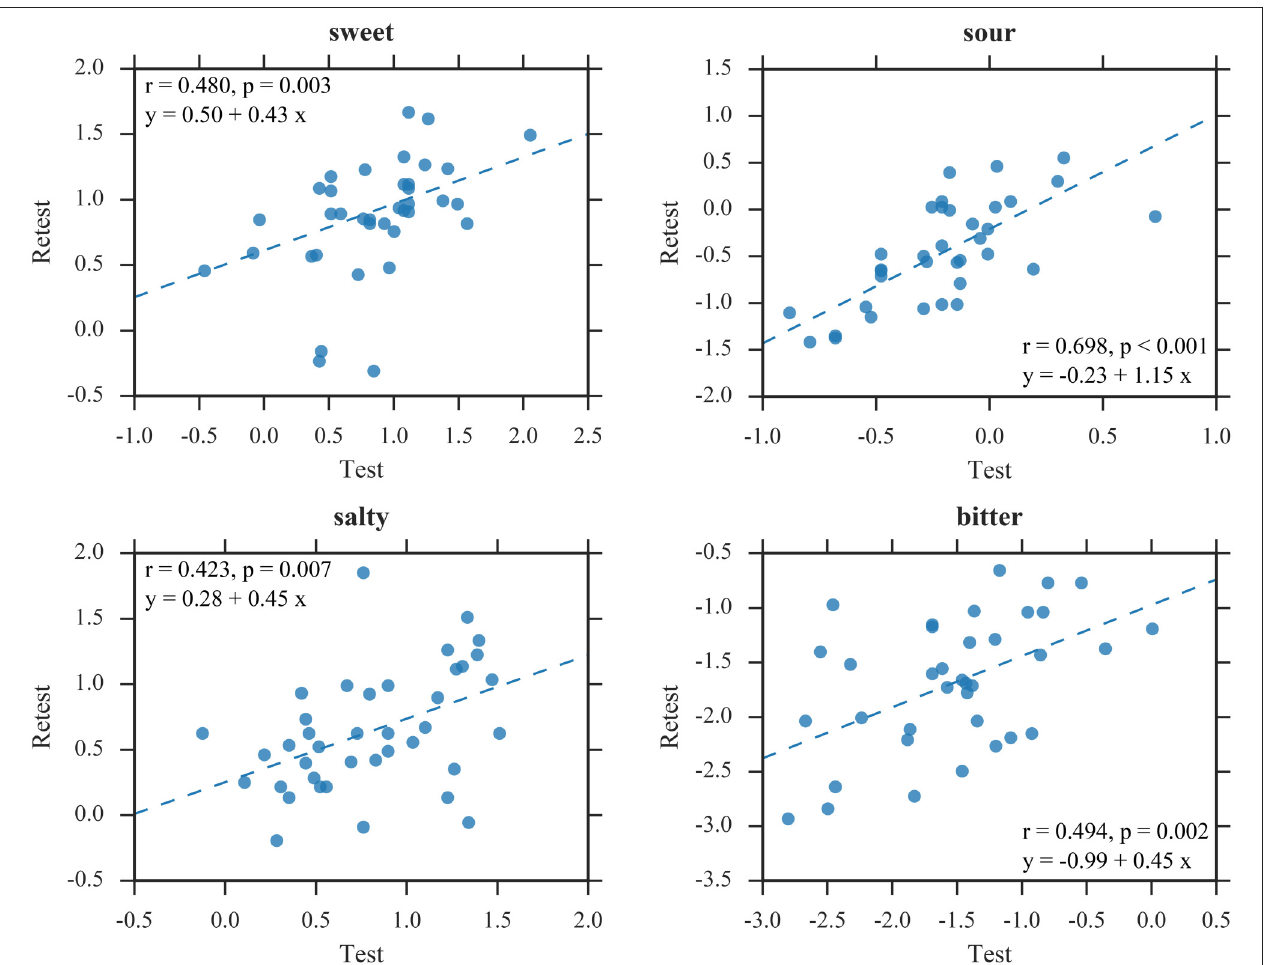
FIGURE 7 | Test-retest correlations of SIAM thresholds. All values in log 10 m M